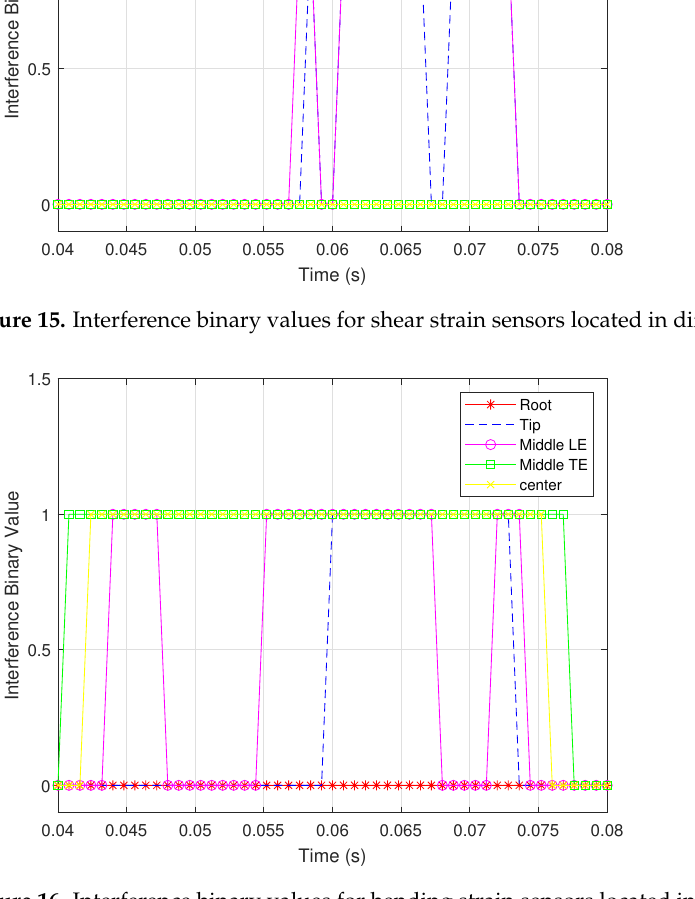
Figure 16. Interference binary values for bending strain sensors located in different